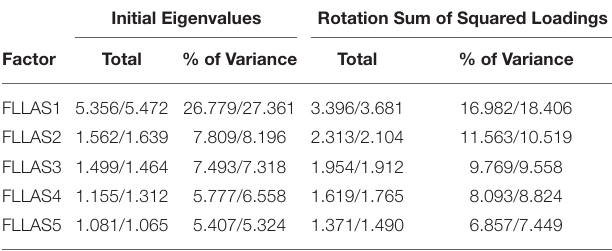
TABLE 3 | Eigenvalues and explained variances of FLLAS factors.